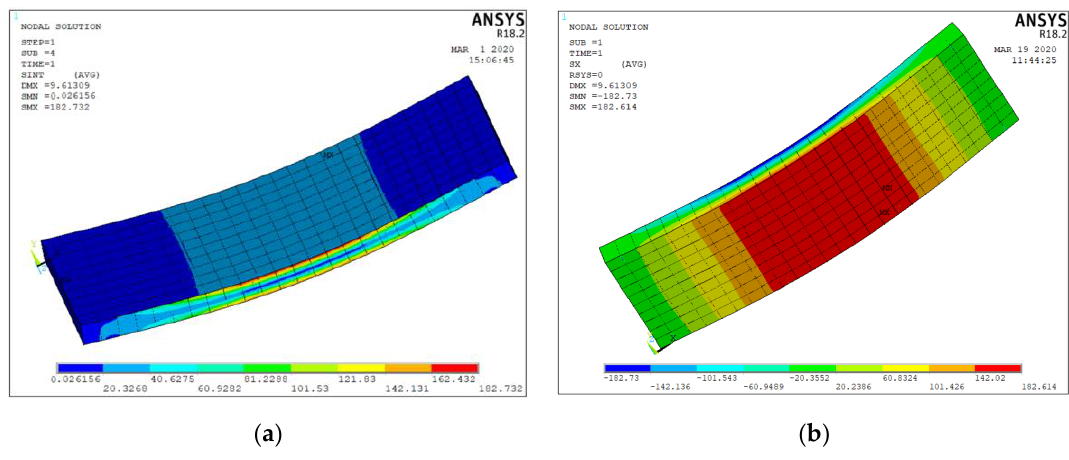
Figure 16. Stress nephogram of composite floor: ( a ) concrete stress nephogram of composite floor and ( b ) steel plate stress nephogram of composite floor along X direction.